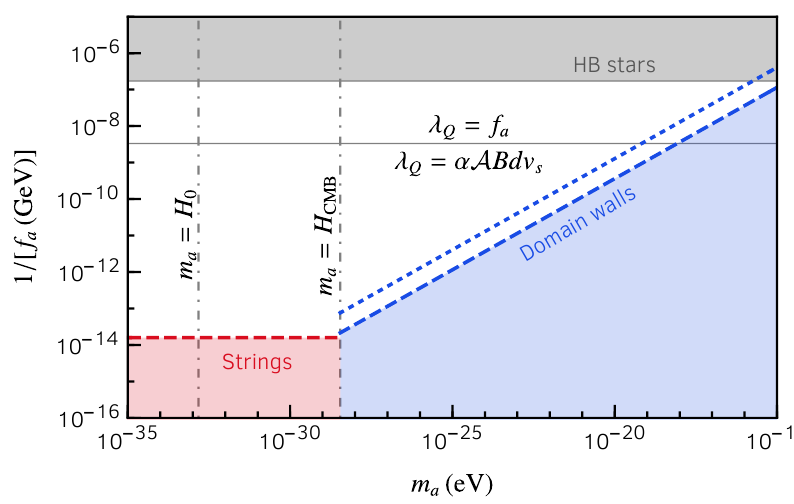
Figure 3 . The open parameter space of hyperlight axions. The gray shaded region is excluded by cooling bounds coming from Horizontal Branch stars [45] (assuming A = 1 ). The red shaded region is excluded by CMB measurements of strings coming from their gravitational effects [46]. The blue region is excluded when N = 1 due to the temperature fluctuations induced by the gravitational DW 6 potential of the domain wall [47]. Dashed and dotted blue and red lines correspond to ξ = 10 and 100 , respectively. The horizontal gray line divides the parameter space into two parts. In the lower region, the charge density is always smaller than f , and the charge density is set by the magnetic a field properties in the galaxy (see section 5.4). In the upper region, the charge density λ on the Q string core can reach and saturate at f (assuming m = f ), and the string can potentially be a PQ a trapped by a galaxy (see section 5.5). The signals discussed in this paper apply to ξ ≥ 1 in all of the allowed parameter space in this